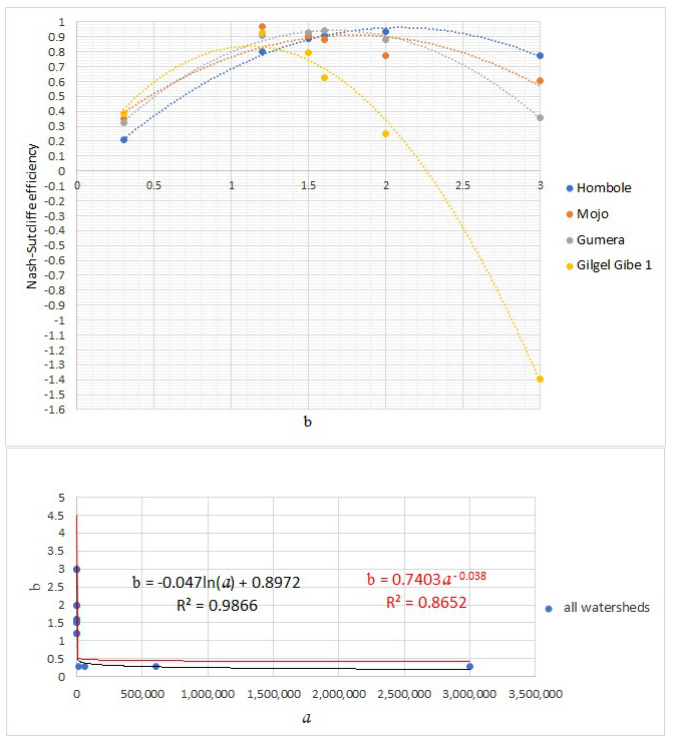
Figure 13. The relationship between exponent b versus the Nash–Sutcliffe efficiency and coefficient a versus exponent b when the topographic factor is calculated using the Chines equation.